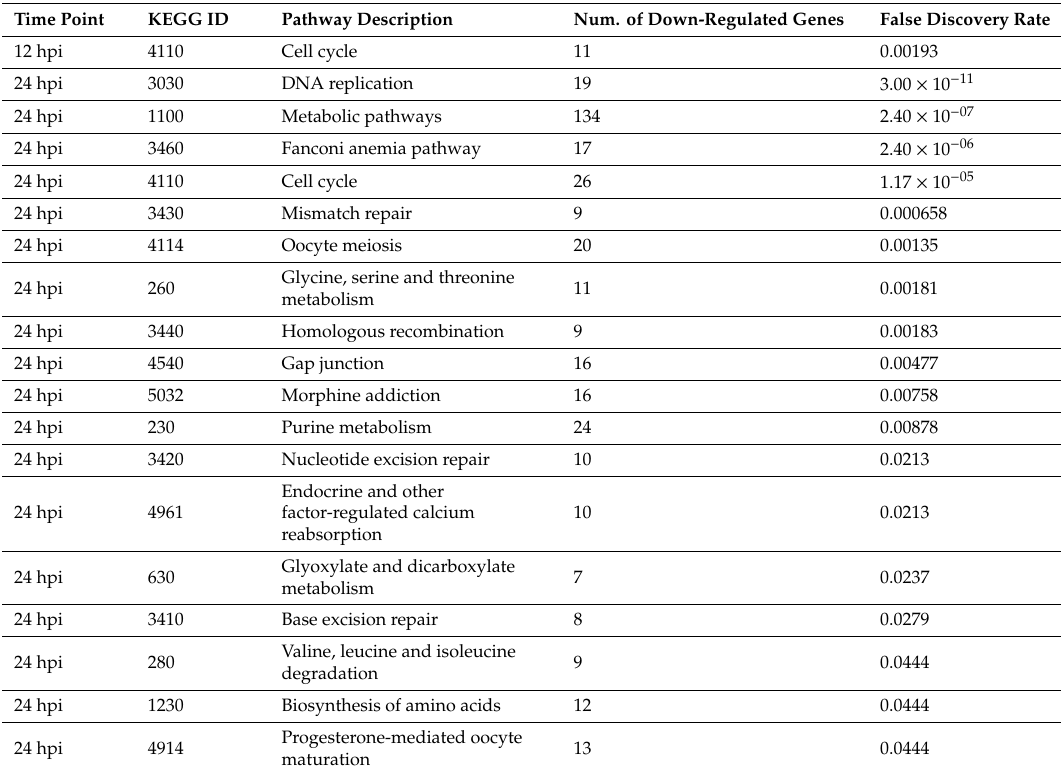
Table 2. KEGG pathways significantly enriched in down-regulated gene sets of 12 and 24